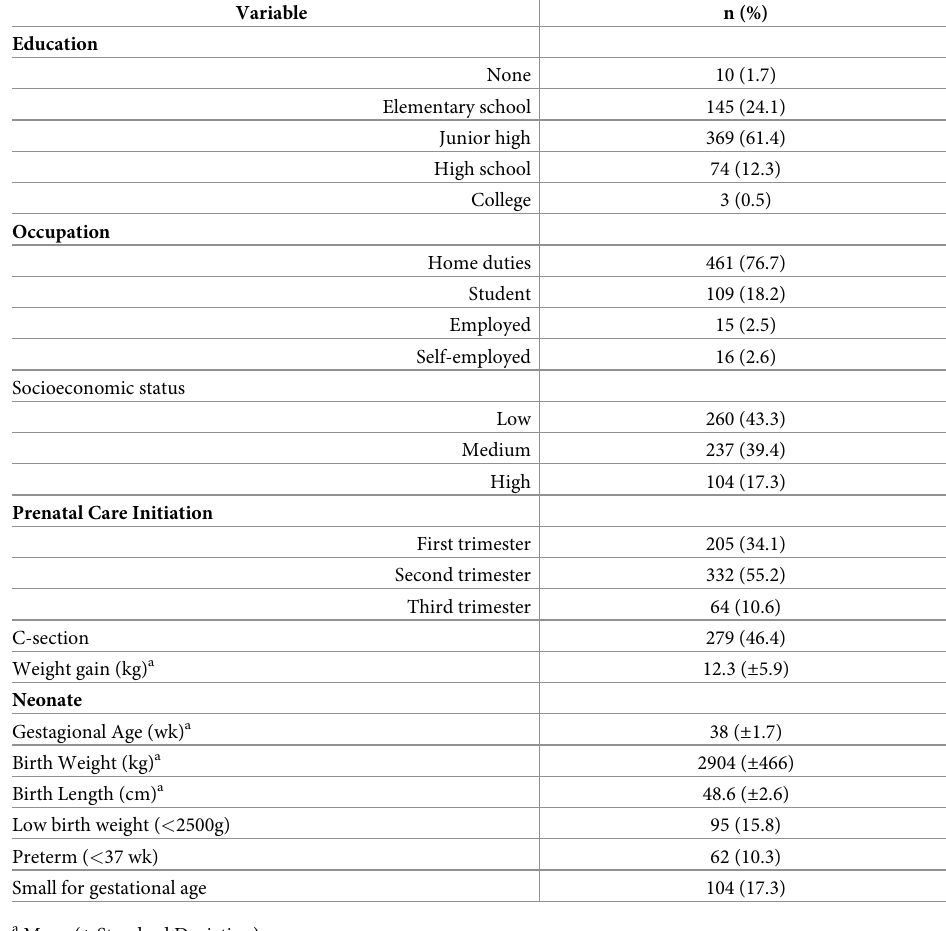
Table 2. Characteristics of the studied population (n =